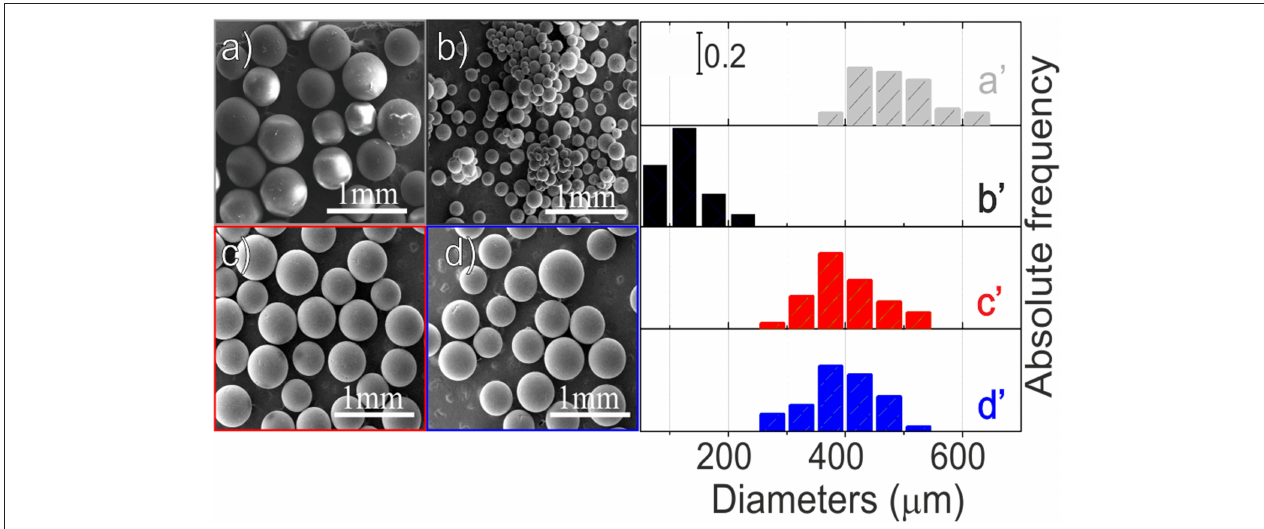
FIGURE 1 | Low-resolution SEM images (left panel) of: PS-co-DVB spheres (a) , PS-co-DVB spheres after pyrolysis at 800 ◦ C for 5h (b) , ZnCl 2 activated carbon microspheres, after thermal treatment at 800 ◦ under N 2 (c) , carbonized ZnCl 2 /carbon microspheres after impregnation with Fe(NO 3 ) 3 and then thermal treatment at the same temperature (d) ; size distributions (right panel) of spheres at the different steps of preparation: polymer material before (a ′ ) and after pyrolysis at 800 ◦ C (b ′ ) , ZnCl 2 -activated microspheres (c ′ ) and the same ZnCl 2 -based spheres impregnated with Fe(III) after their thermal treatments at 800 ◦ C (d ′ )